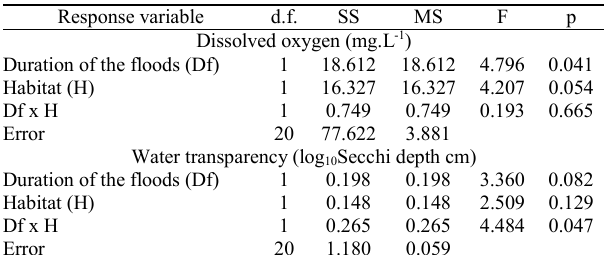
Table 1. Results of the ANOVAs that examined the main effects (duration of the floods and habitat ) on the selected abiotic variables (dissolved oxygen and water transparency) in the upper Paraná River floodplain, between 2000 and 2003. d.f. = degrees of freedom; SS = sum of squares; MS = mean square; F = ratio of variance between and within groups; p = probability of Type 1 error.